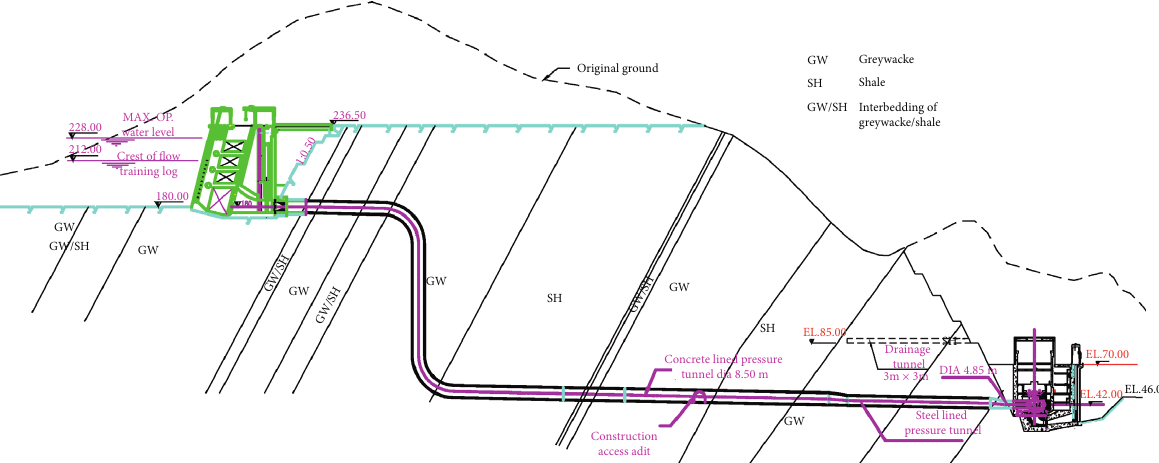
Figure 2: Longitudinal section of the power tunnel. Table 1: Geomechanical property parameters of the surrounding rock